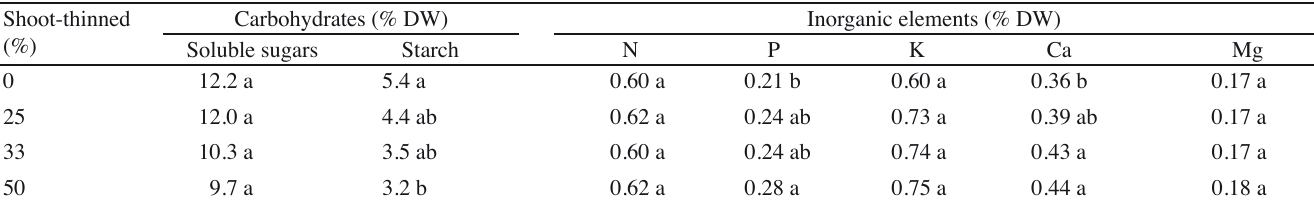
Table 3 - Effect of removing water sprouts on 28 July on light penetra - tion and fruit characteristics in vigorous ‘Fuyu’ persimmon orchard (Choi et al ., 2005)